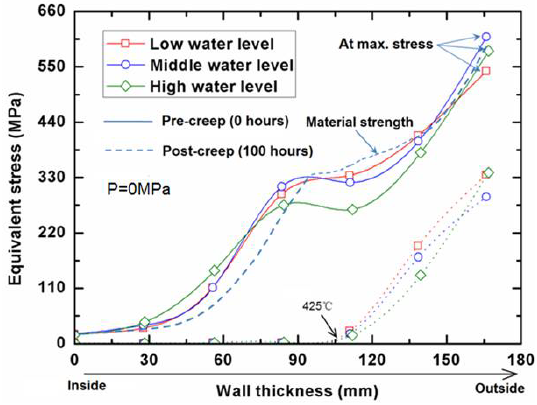
Figure 6. Effect of internal pressure on plastic strain distribution for RPV with low water level.